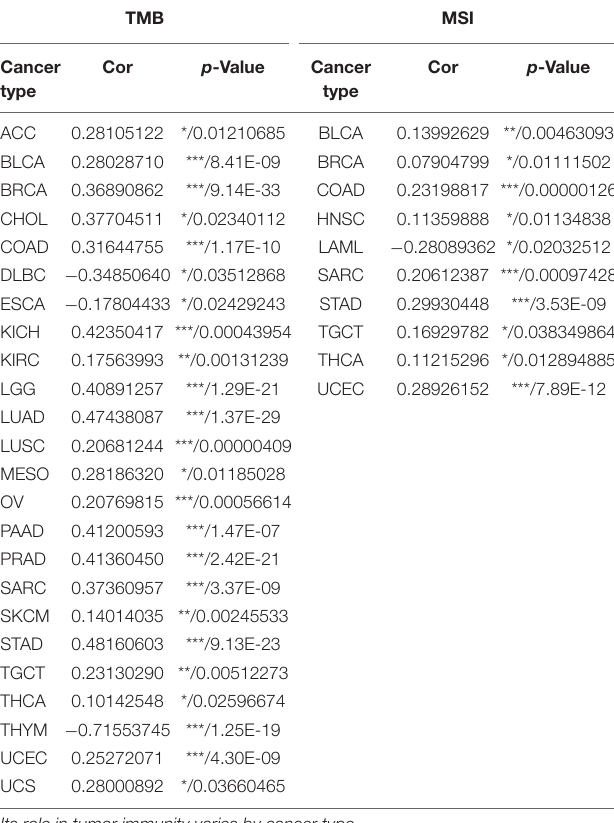
TABLE 1 | Correlation between PIMERG expression and TMB,